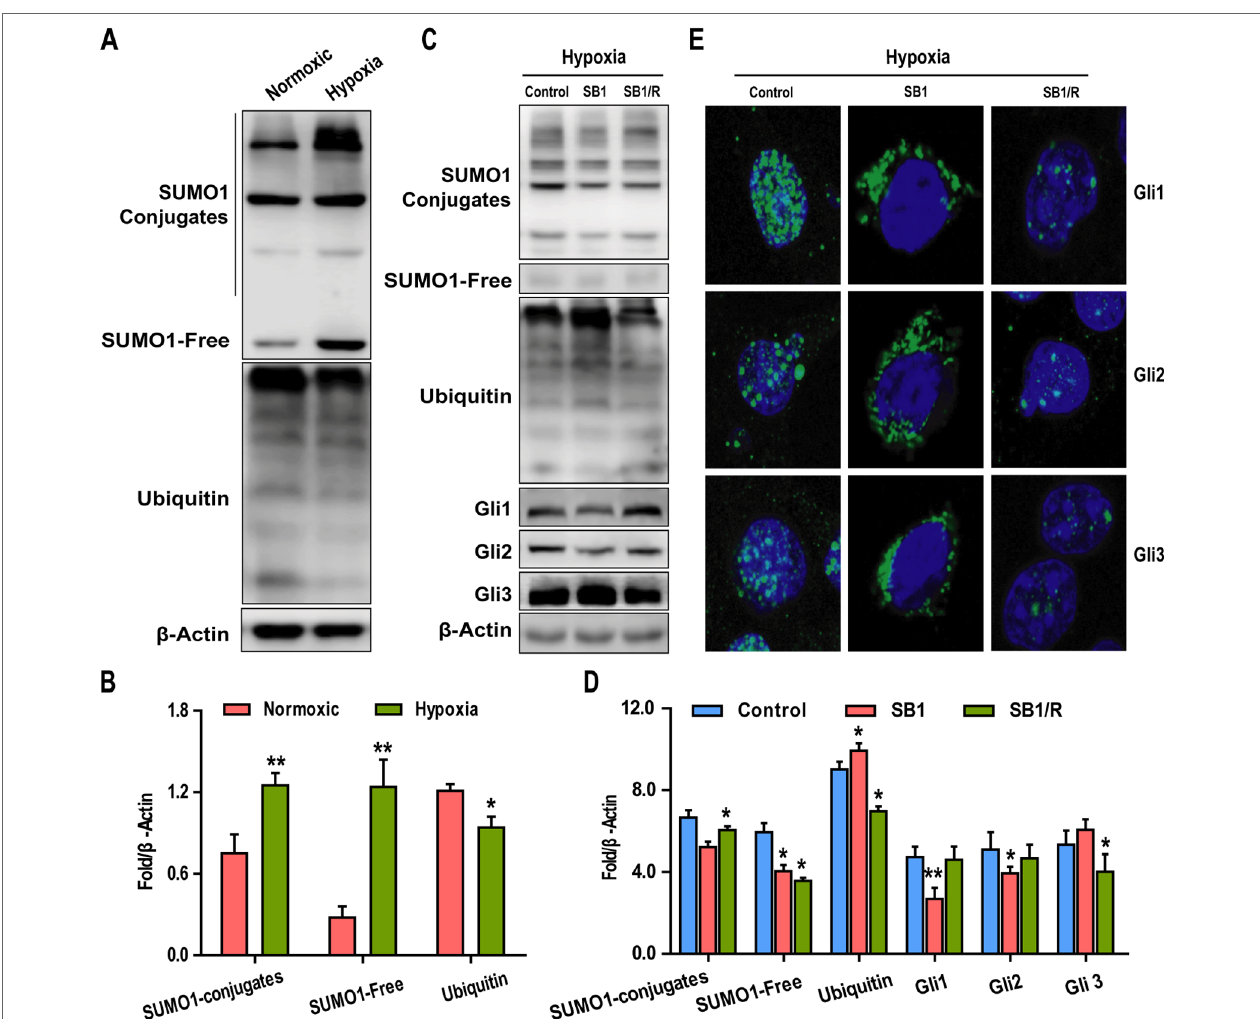
FIGURE 4 | SUMOylation is required for the hypoxia-dependent activation of GLI proteins. (A , B) The expressions of SUMO1, Ubc9, and Ubiquitin under normoxic and hypoxic conditions were examined by western blotting. (C , D) Western blotting analysis of SUMO1, Ubc9, Ubiquitin, and Gli1-3 expression in Hep3B cells subjected to the indicated treatments. (E) The subcellular localization of GLI proteins in Hep3B cells treated as in C was examined by immunofluorescence (IF) (scale bar, 50 µm). DAPI was used to stain cell nuclei. Data are shown as means ± SD (n = 3); * P < 0.05 and ** P < 0.01 when compared with control (Student’s t